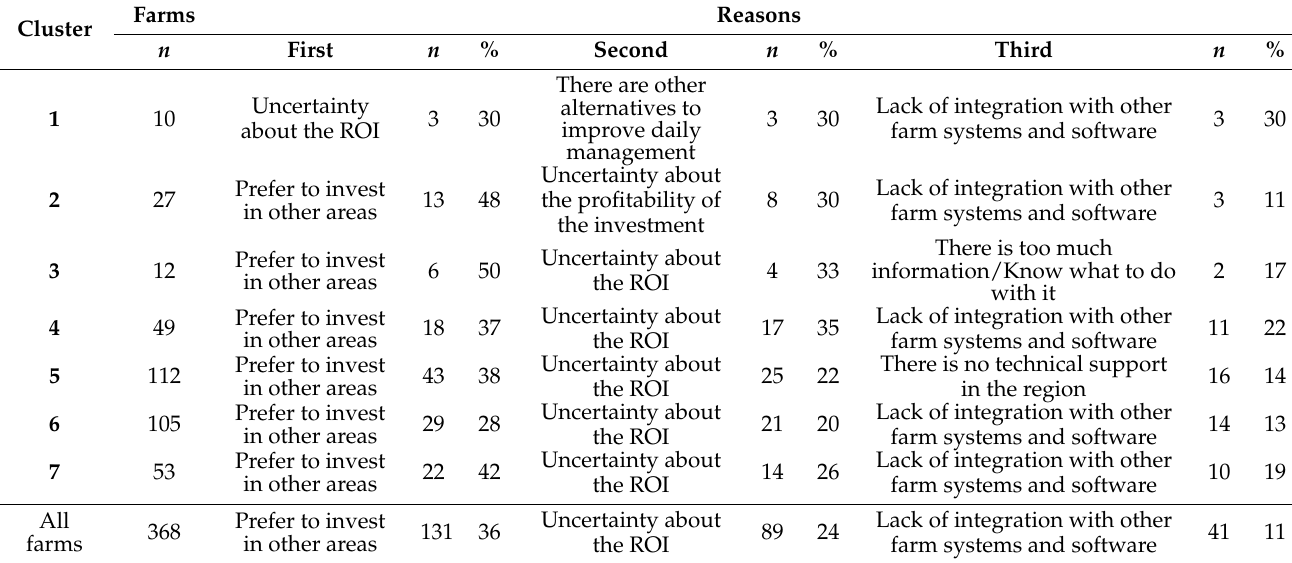
Table 7. Top three reasons to not invest in precision